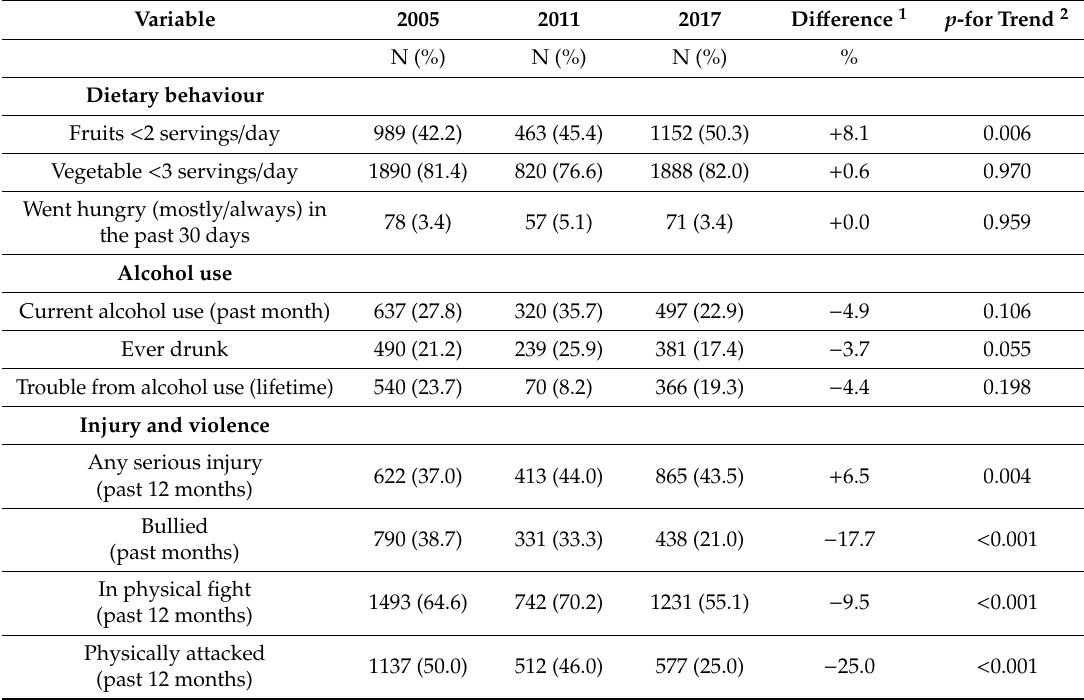
Table 3. Health risk behaviours in 2005, 2011 and 2017 among male in-school adolescents in